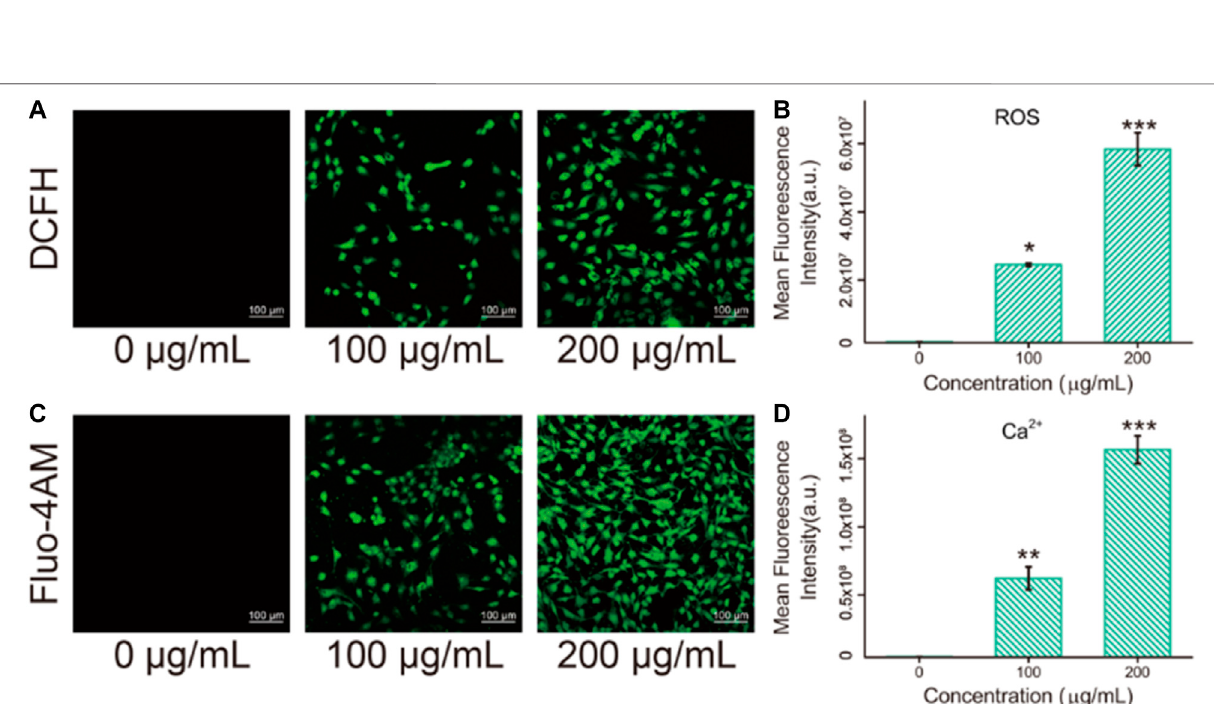
Frontiers in Chemistry |